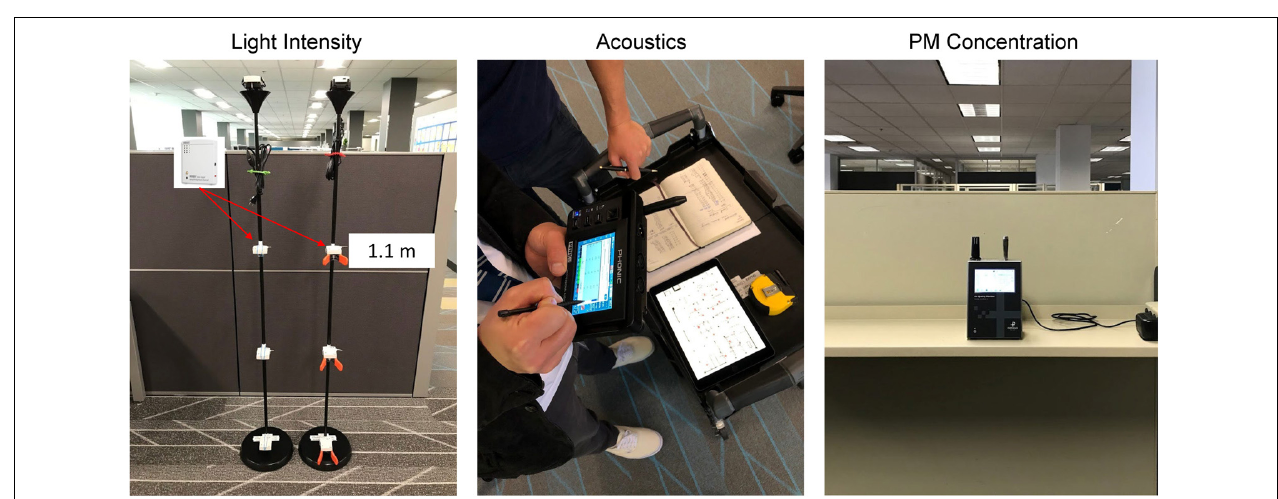
FIGURE 2 | Measurement locations for various environmental parameters pre- and post-retrofit.